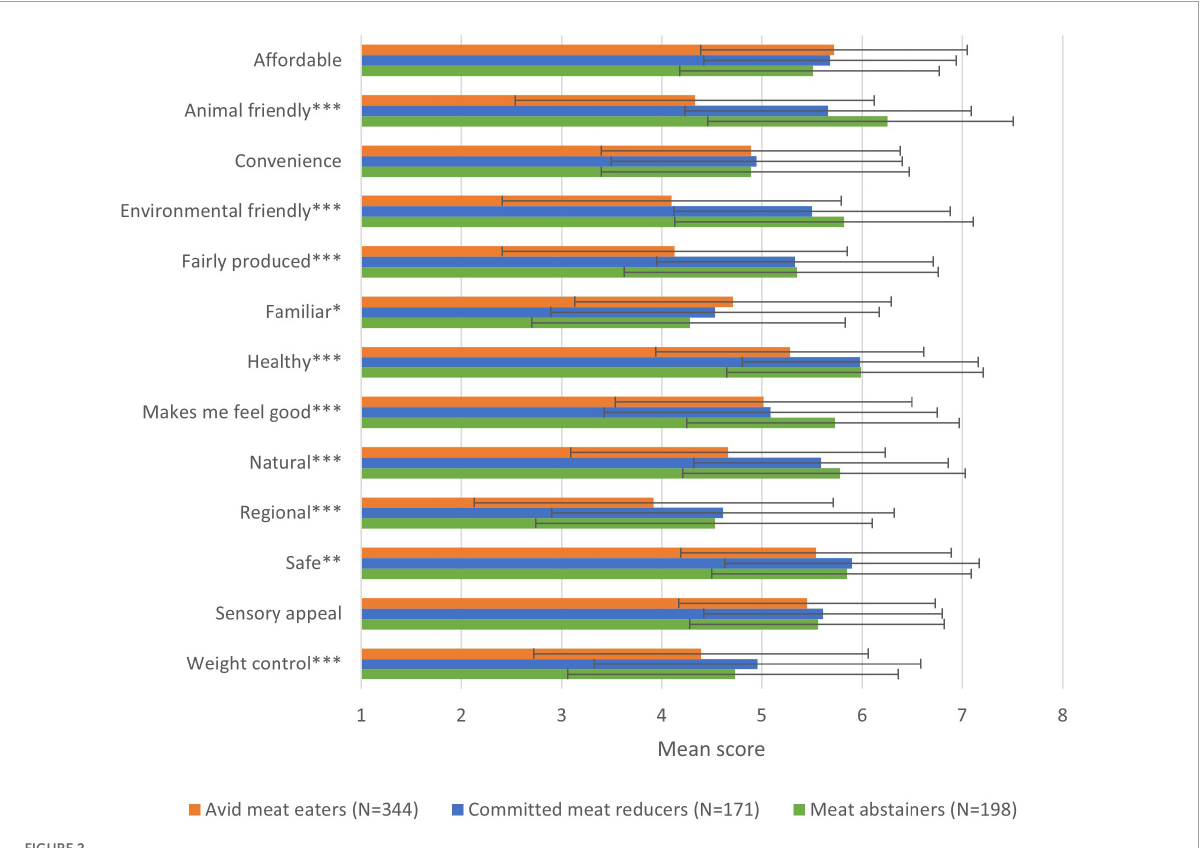
FIGURE2 Mean scores of food choice motives per dietary consumer group (* p < 0.05, ** p < 0.01, *** p <